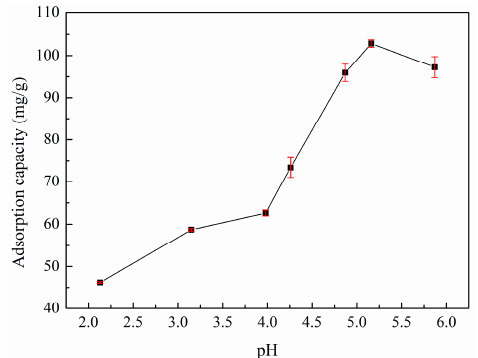
Figure 4. Effect of the pH values on the adsorption capacity of XSBLAC for zinc(II). (Adsorption experiments-sample dosage: 0.05 g; initial zinc(II) concentration: 0.015 mol/L; pH range: 2.0–6.0; temperature: 60 °C; adsorption time: 40 min).